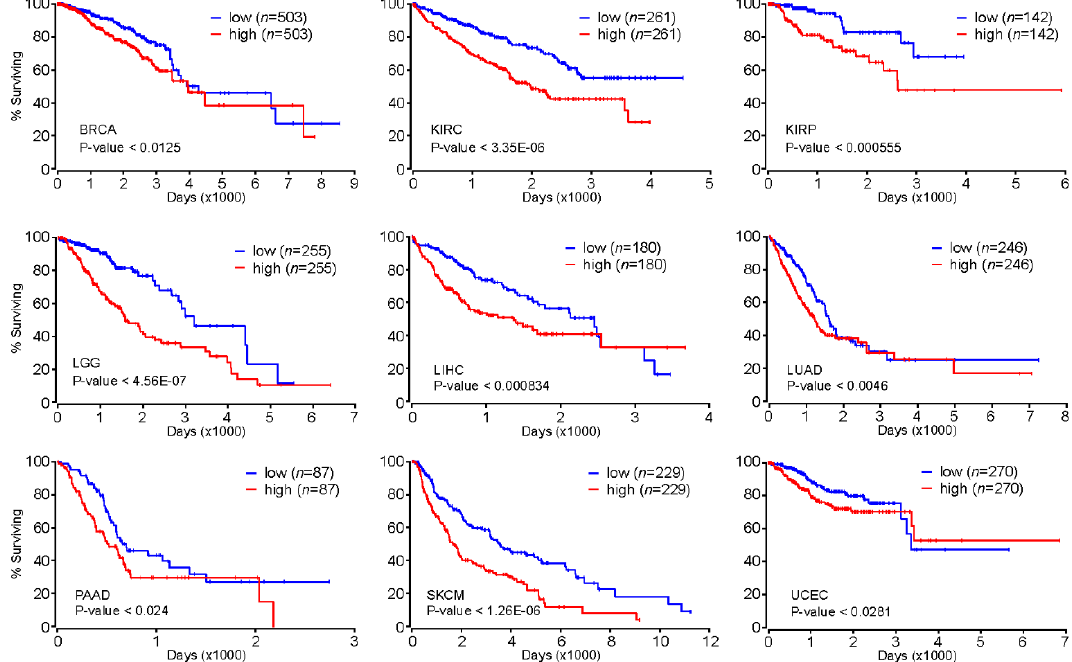
Figure 5. Kaplan–Meier survival analysis based on the FOXM1 expression level. Kaplan–Meier (KM) survival analysis was conducted using Oncolnc (http://www.oncolnc.org/). Patients were divided into high (50%) or low (50%) groups based on the expression level of the FOXM1 gene.